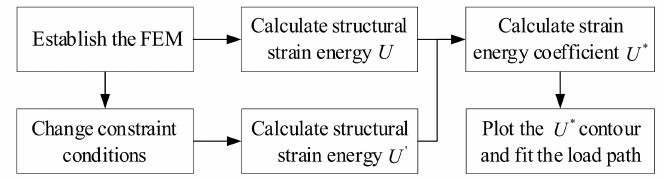
Figure 3. Flow chart of the load path calculation.